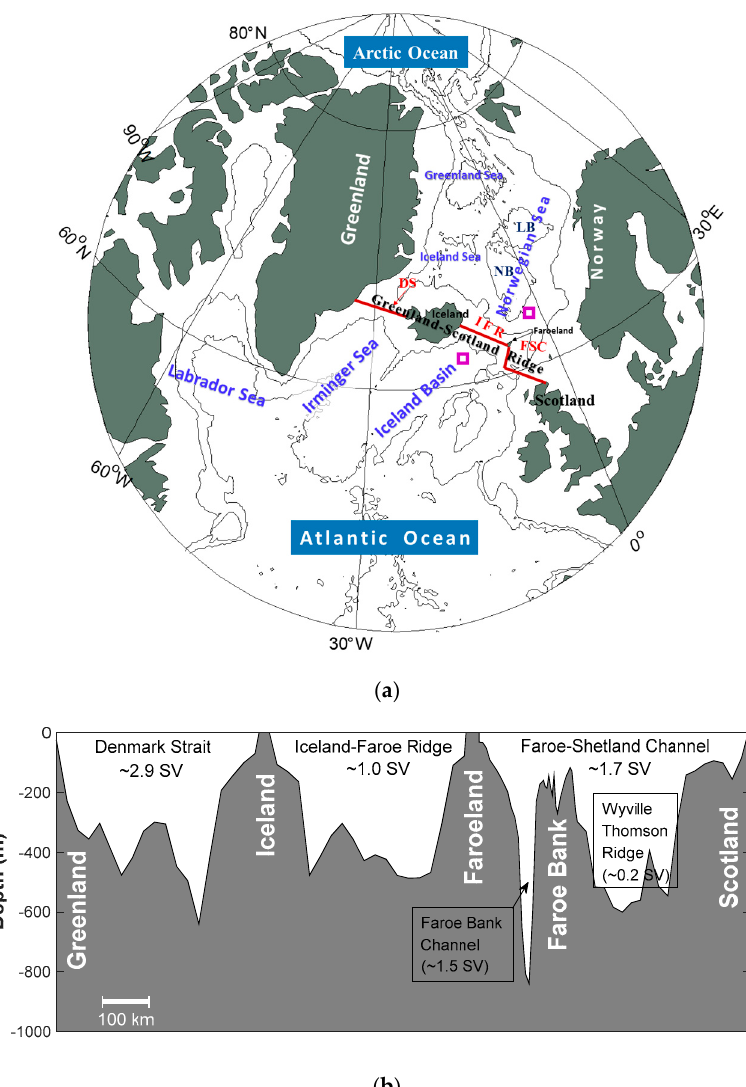
Figure 1. ( a ) Topographic map of the Nordic Sea and ( b ) bottom depth map of the GSR. Note: The Nordic Sea is composed of the Norwegian Sea, the Icelandic Sea, and the Greenland Sea. In the Norwegian Sea, LB stands for the Lofoten Basin and NB stands for the Norwegian Basin; the DS, IFR, and FSC stand for the three main overflow channels in Greenland-Scotland Ridge, namely Denmark Strait, Iceland-Faroe Ridge, and Faroe-Shetland Channel, respectively; the purple square represents the selected point for calculating the pressure difference between the two sides of the GSR; the red line is the selected section for the bottom depth map. Bottom depth of the oceanic part of the GSR and overflow flux are based on Hansen and Østerhus [2].